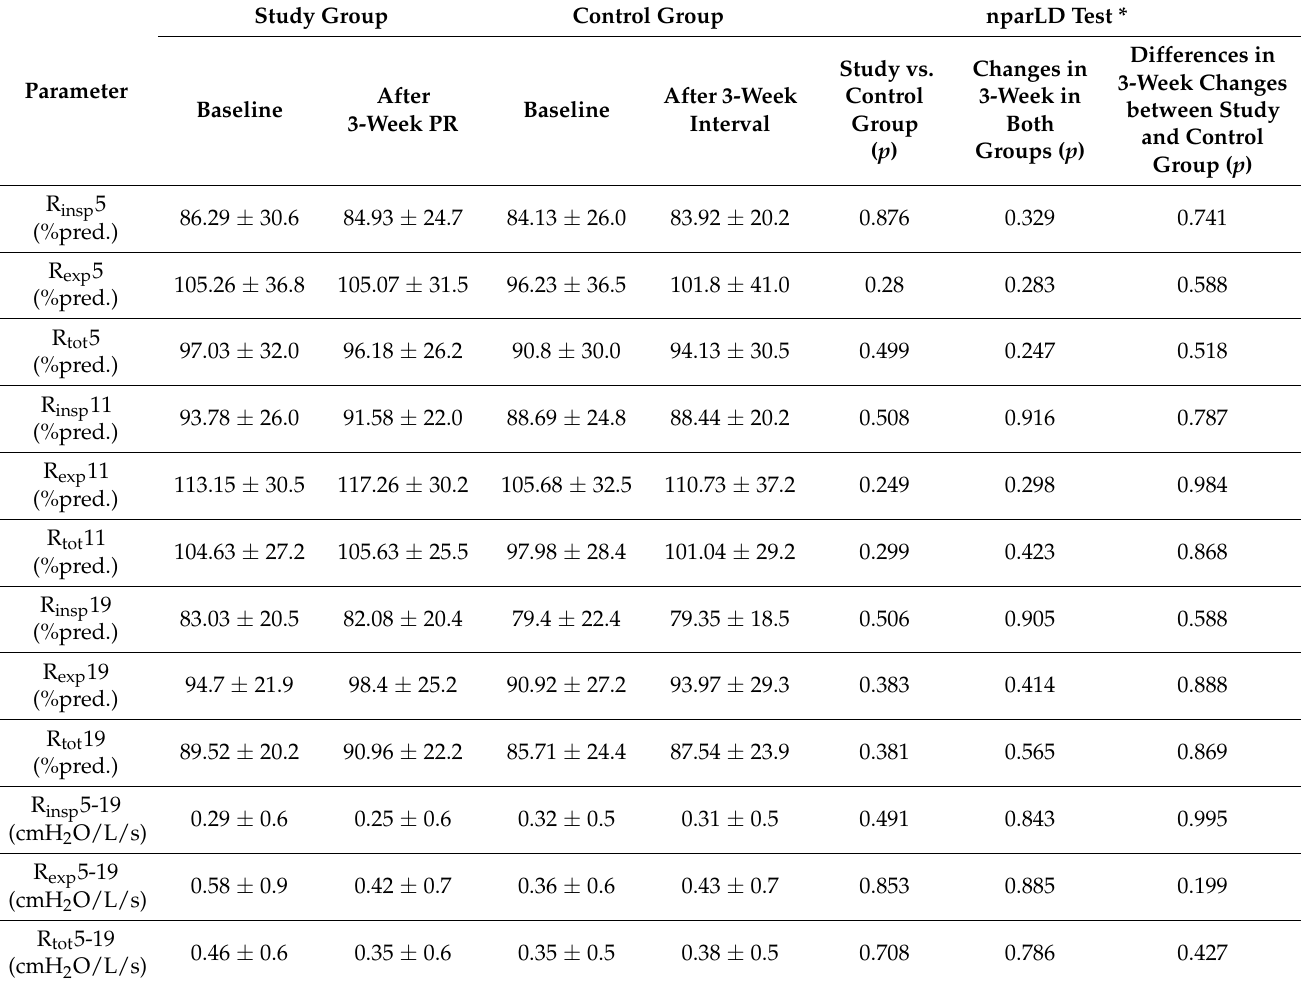
Table 3. Resistance (R) at the baseline and after 3 weeks of pulmonary